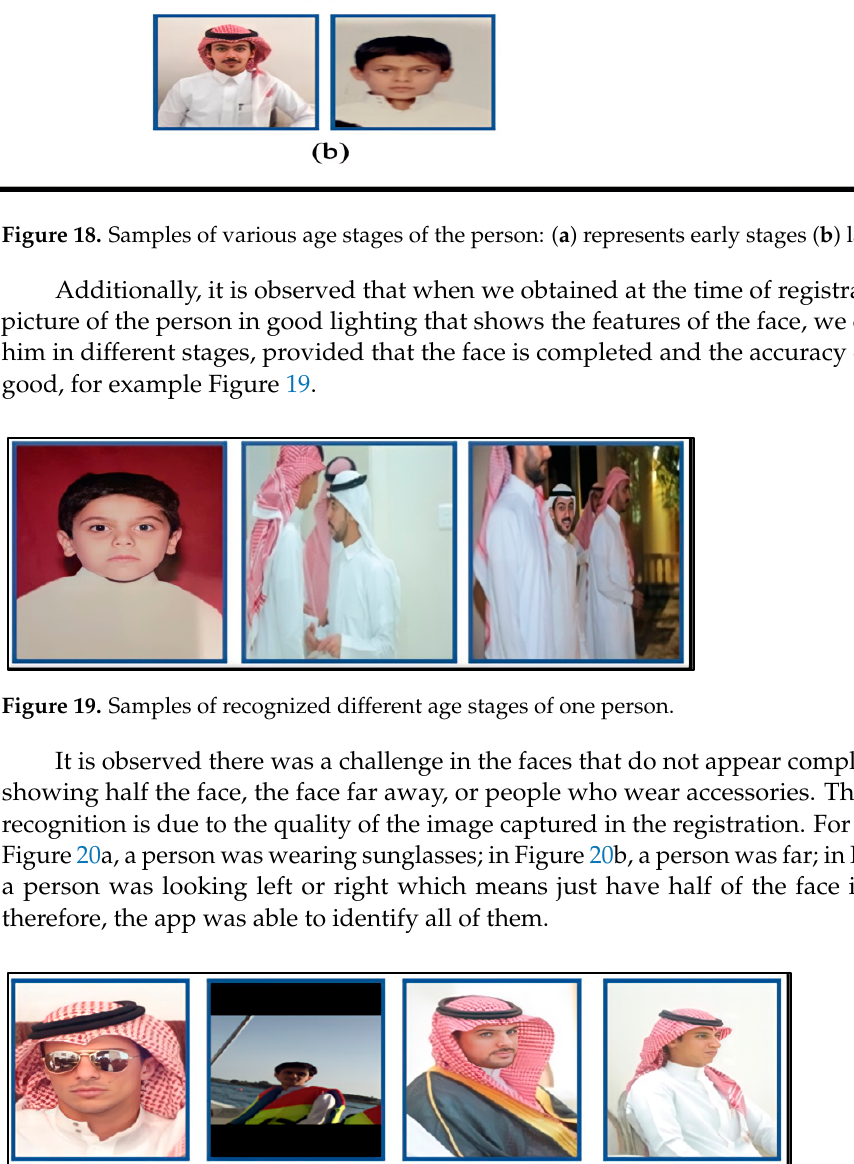
Figure 17. Samples of recognized and not recognized faces: ( a ) represents recognised faces and ( b ) represents unrecognised faces .